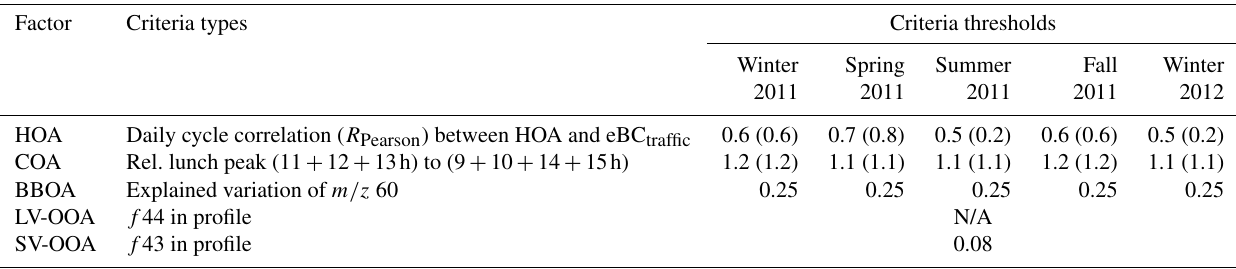
Table 2. Criteria scheme employed in this study. The first value represents the applied threshold for the final PMF solution and the values in brackets for HOA and COA stand for the threshold value coming from the seasonal resampling analysis. f 44 for LV-OOA is used for factor sorting rather than as an acceptance/rejection